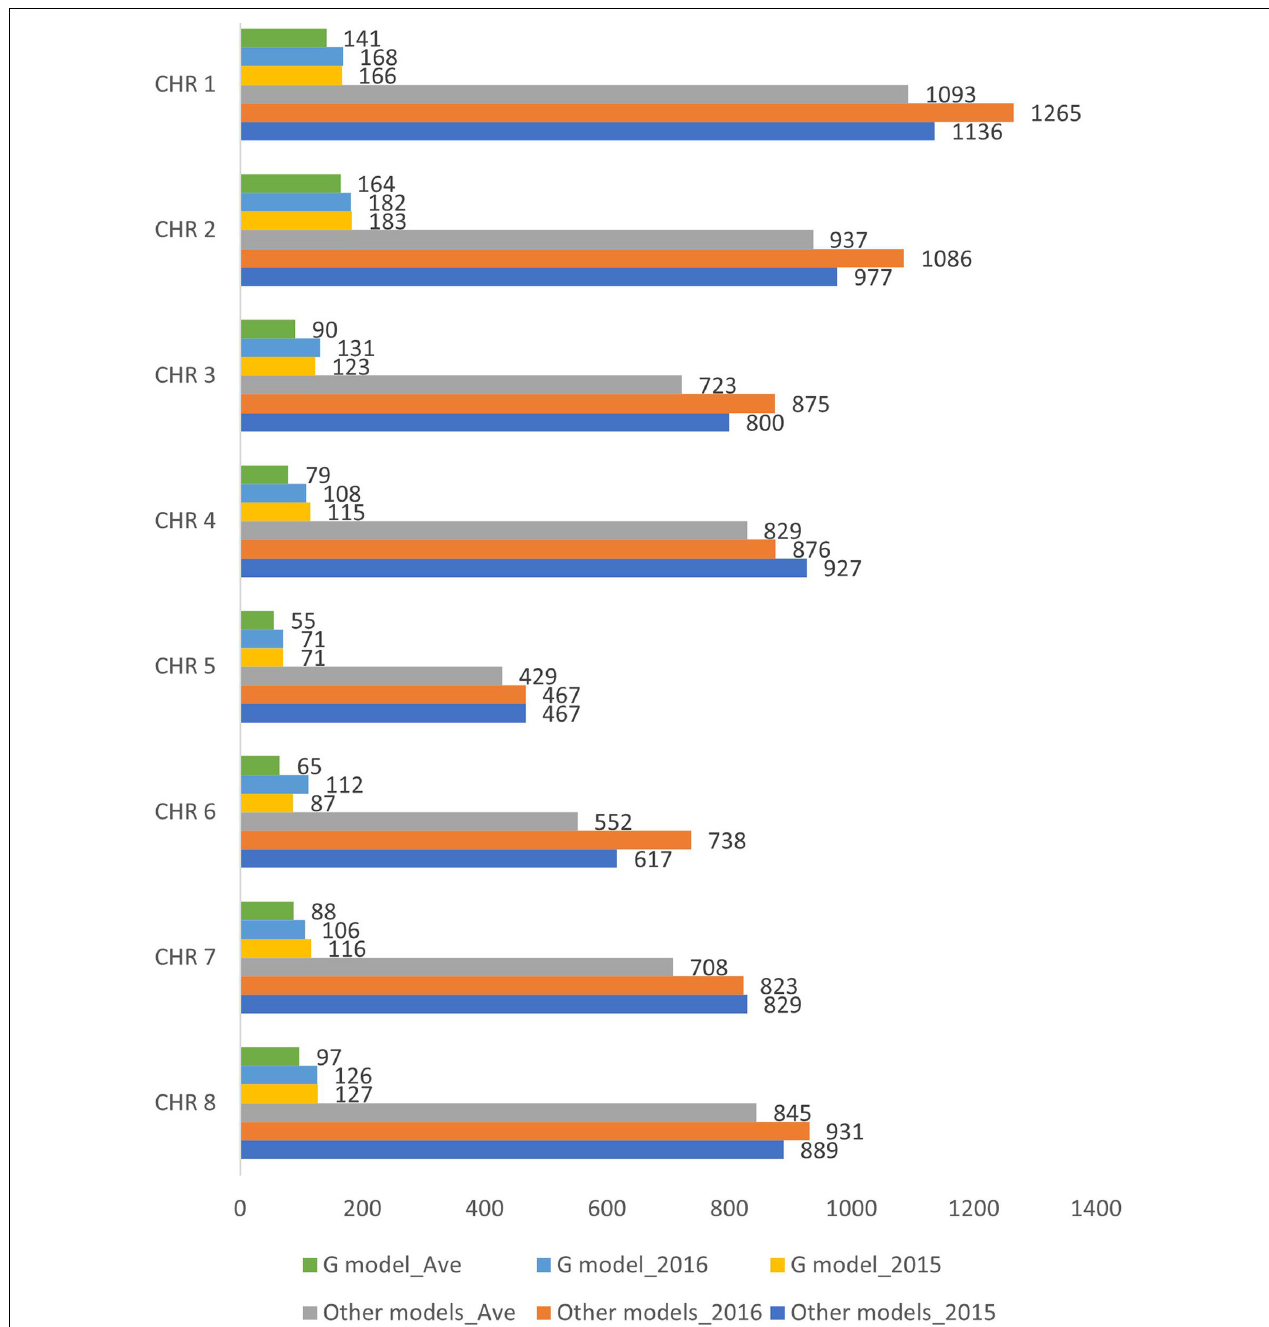
FIGURE 2 | Number of SNPs included in the genome wide association analysis for the six datasets (G model_2015, G model_2016 G model_Ave, Other models_2015, Other models_2016 and Other models_Ave). CHR, chromosome.